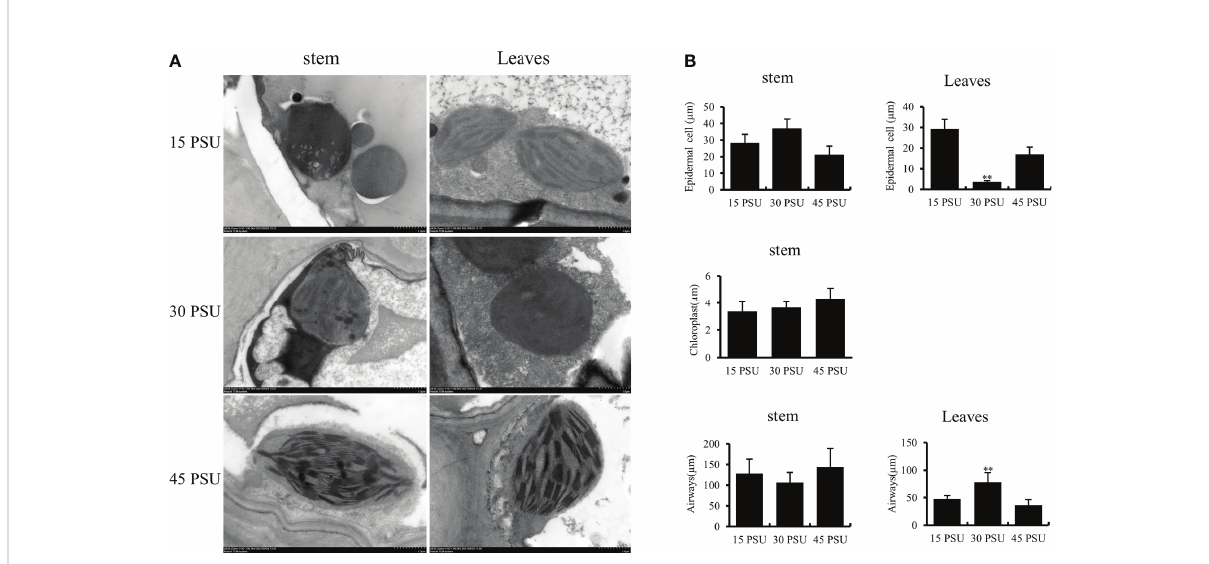
FIGURE 3 Images of the structure of T. hemprichi observed under Transmission electron microscopy (TEM). (A) Transmission electron microscopy (TEM) result; (B) (EC) Epidemic cell, Chloroplast, and Airways analysis. The statistical signi fi cance was assessed using Student ’ s t multiple comparisons test. ** P